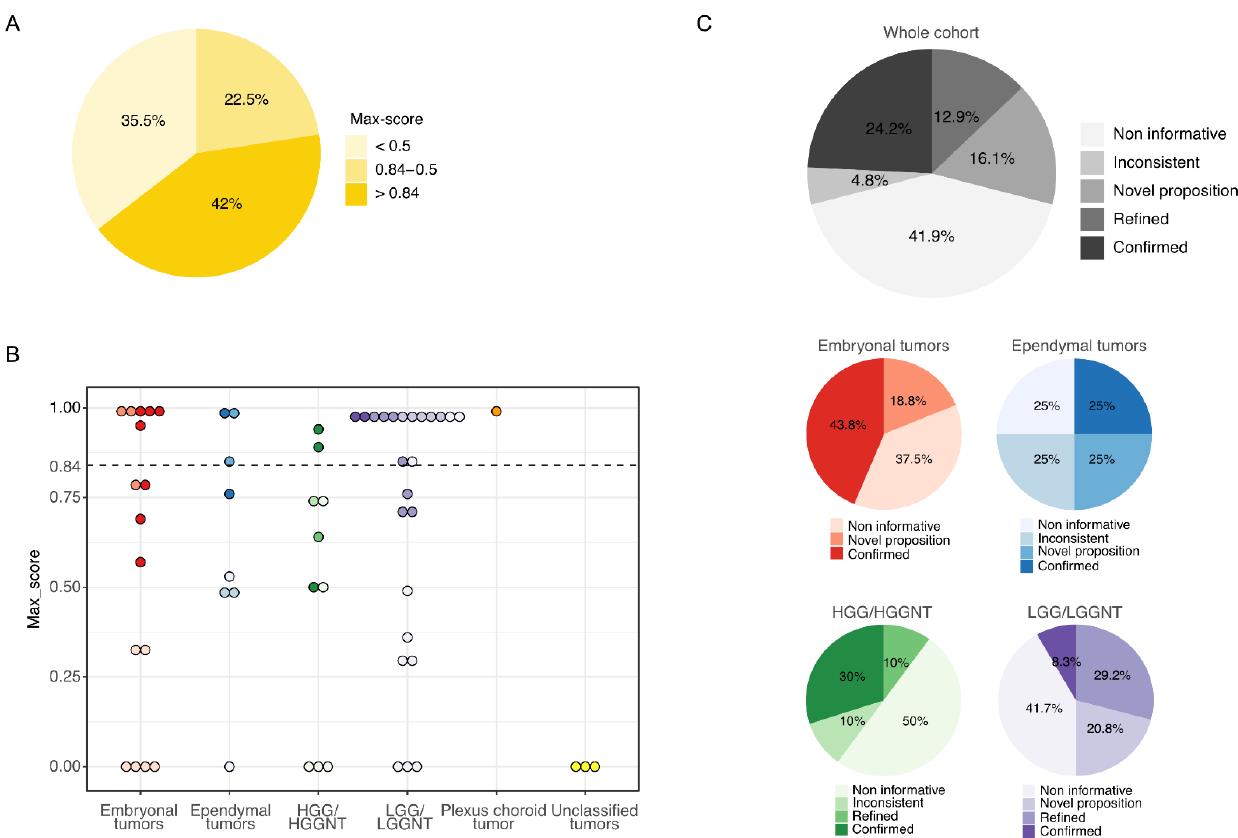
Figure 1. Results from the “classifier” and integration to the morpho-molecular data. ( A ) Proportion of the 62 tumors assigned in a methylation class with a calibrated max-score higher than 0.84 or between 0.5 and 0.84 or lower than 0.5. ( B ) Distribution of the calibrated max-scores in each category of the 62 challenging CNS (central nervous system) pediatric tumors. The color intensity of the dots reflects the integration of the classifier scores to the morpho-molecular data as depicted in 1C. The dotted line represents the threshold of high-confidence according to the recommendations from Capper et al. [10]. ( C ) Integration of the classifier scores to the morpho-molecular data of the whole cohort (top panel) and for each category of tumors (bottom panel). HGG/HGGNT = high-grade glial/glioneuronal tumor. LGG/LGGNT = low-grade glial/glioneuronal tumor.